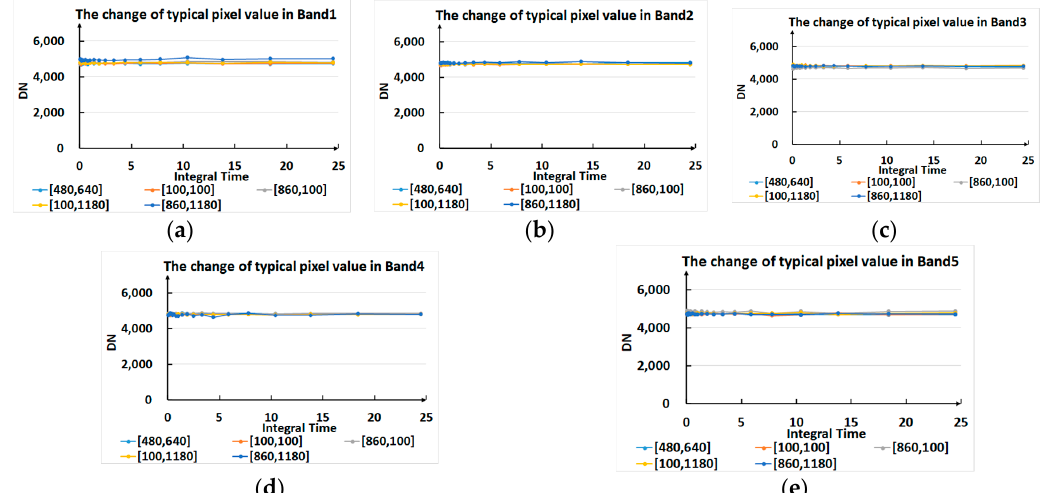
Figure 7. Variation in the typical pixel value as a function of integration time for various bands: ( a ) Band1; ( b ) Band2; ( c ) Band3; ( d ) Band4; ( e ) Band5.